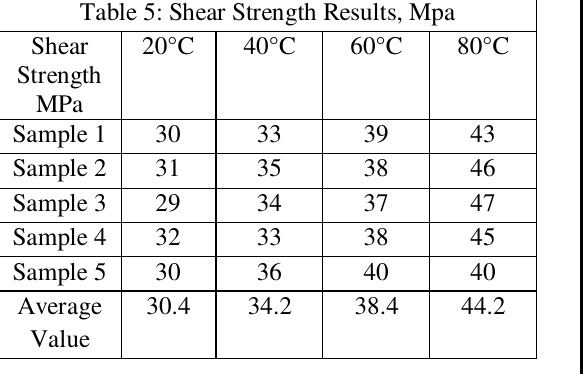
Table 5: Shear Strength Results, Mpa